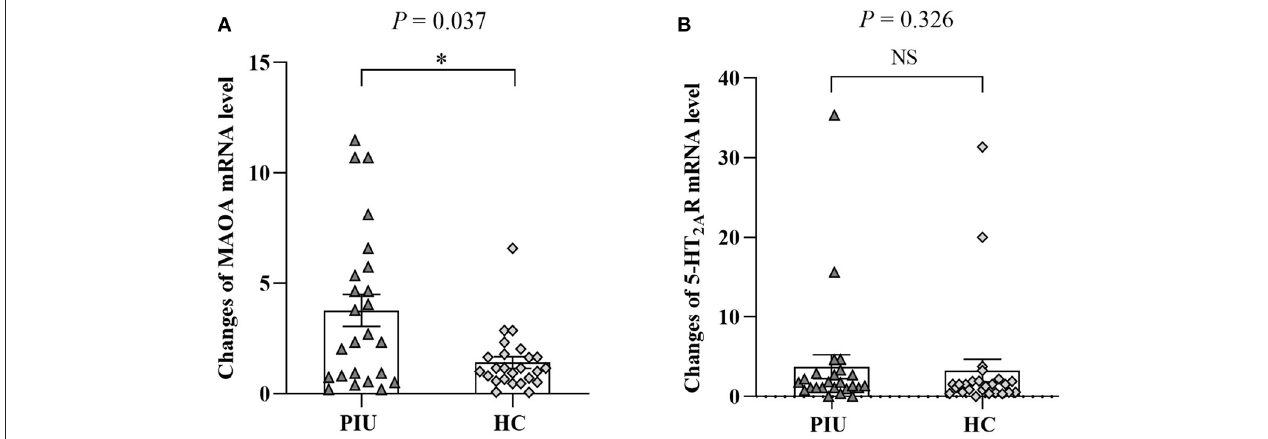
FIGURE 1 | mRNA levels of MAOA (A) and 5-HT 2A R (B) in PBMCs of PIU and HC groups. Bars represent means, error bars represent SEM, triangles, and diamonds represent individual data points ( n = 24 in PIU and 25 in HC groups). * P < 0.05. NS, indicates not